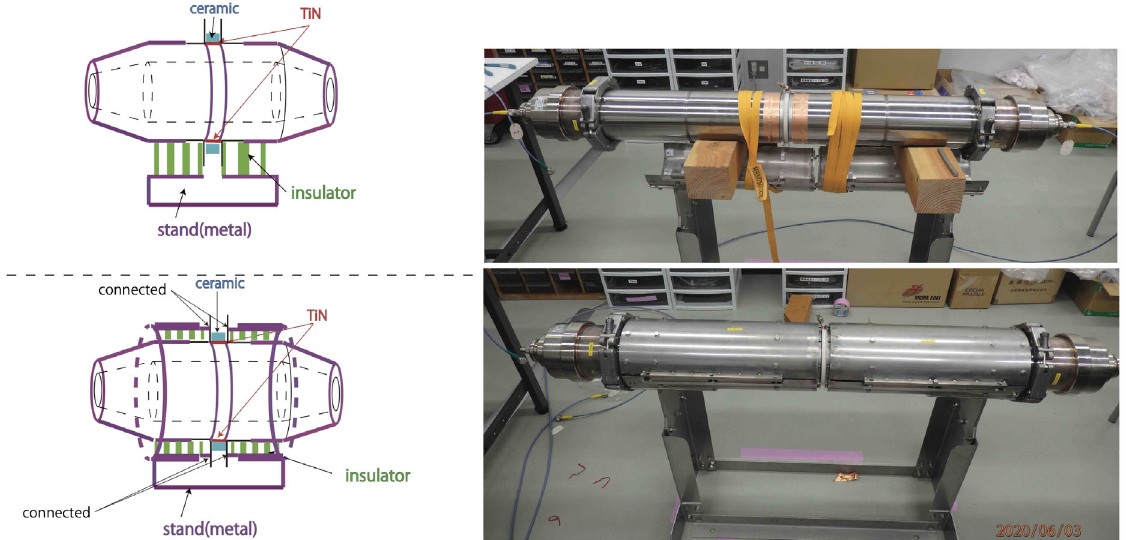
.FIG. 4. Schematics (left) and the photos (right) of the measurement